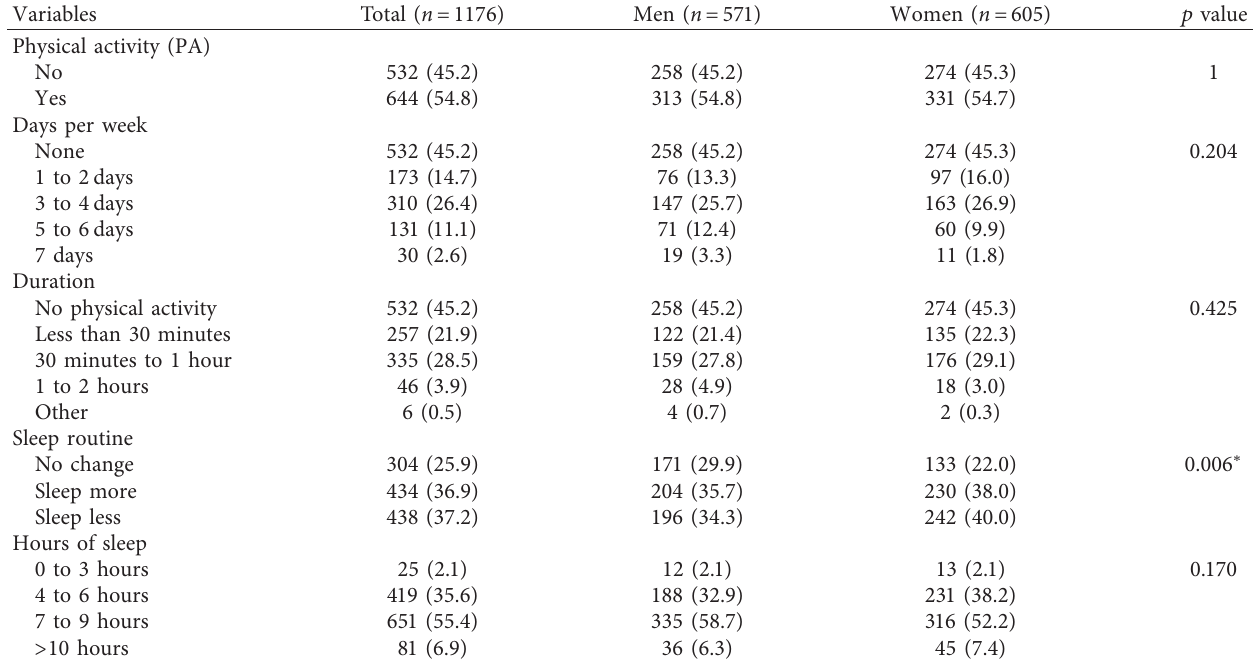
Table 2: Lifestyles during social